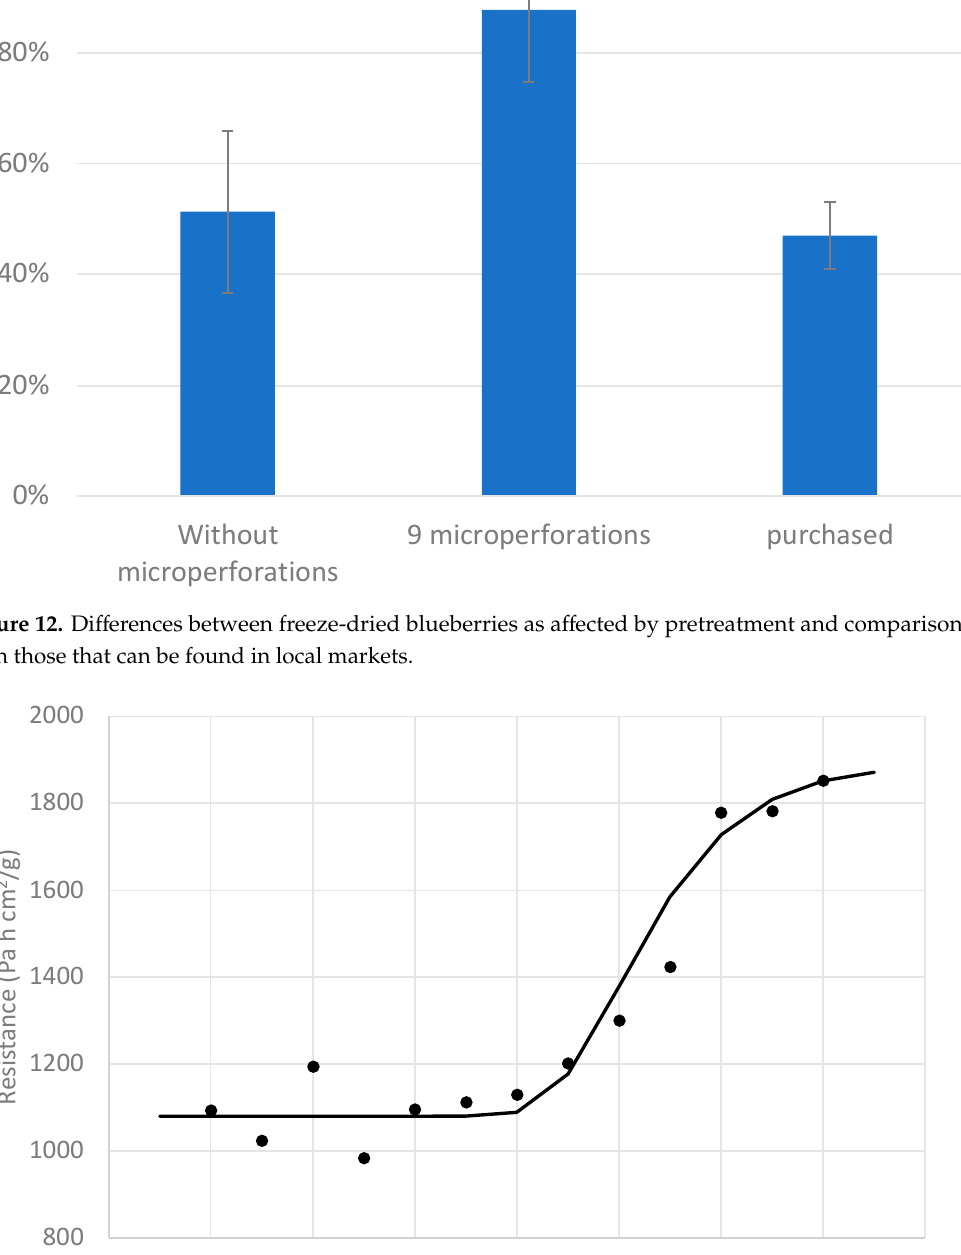
Figure 13. Values of (R T ) along the freeze-drying time ( • ) and its corresponding tendency line ( — ) of cut-in-half treated blueberries.